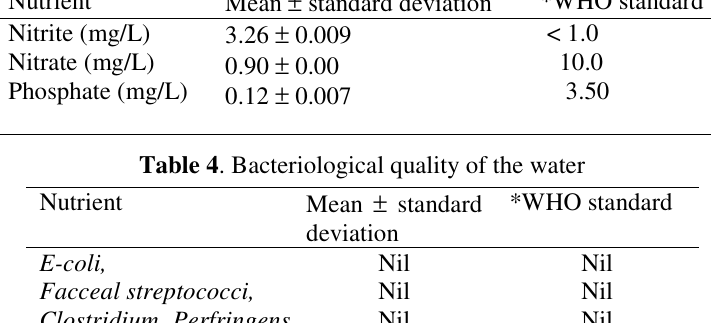
Table 3 . Nutrient content of treated pipe borne water Nutrient